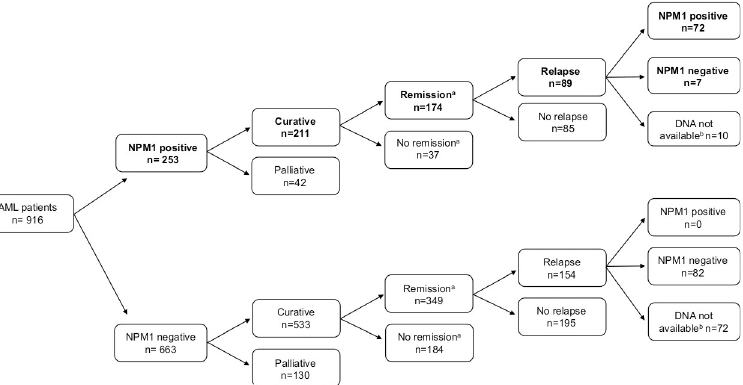
Fig 1. Clinical characteristics of NPM1 positive AML patients. a Remission was defined as morphologic leukemia- free state (MLFS) after induction. b DNA not available at the time point of relapse.